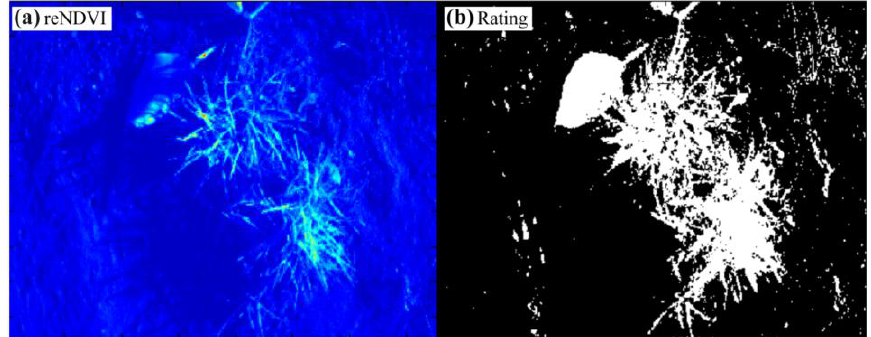
Figure 13. ( a ) Image of the applied reNDVI with the raw data from Figure 10 in rainbow colors from blue (zero) to red (256) and ( b ) the five-point Gaussian filtered binary